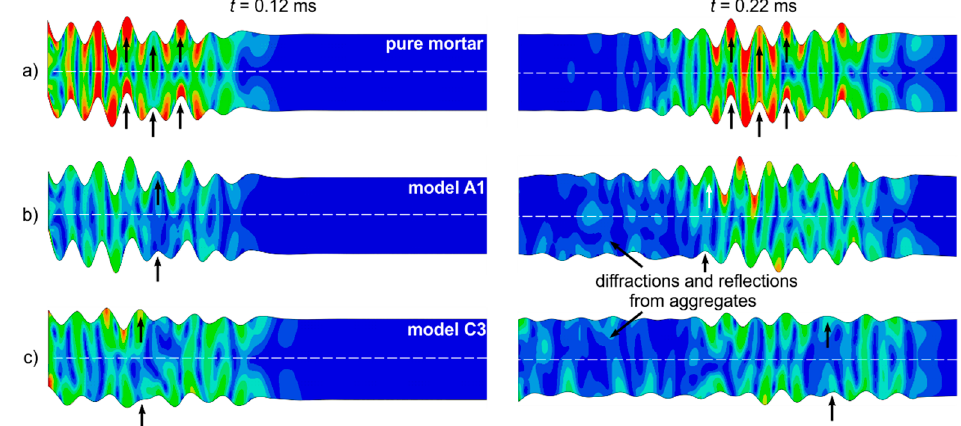
Figure 8. Visualization of wave propagation in ( a ) homogeneous concrete plate, ( b ) heterogeneous model A1, and ( c ) heterogeneous concrete model C3.